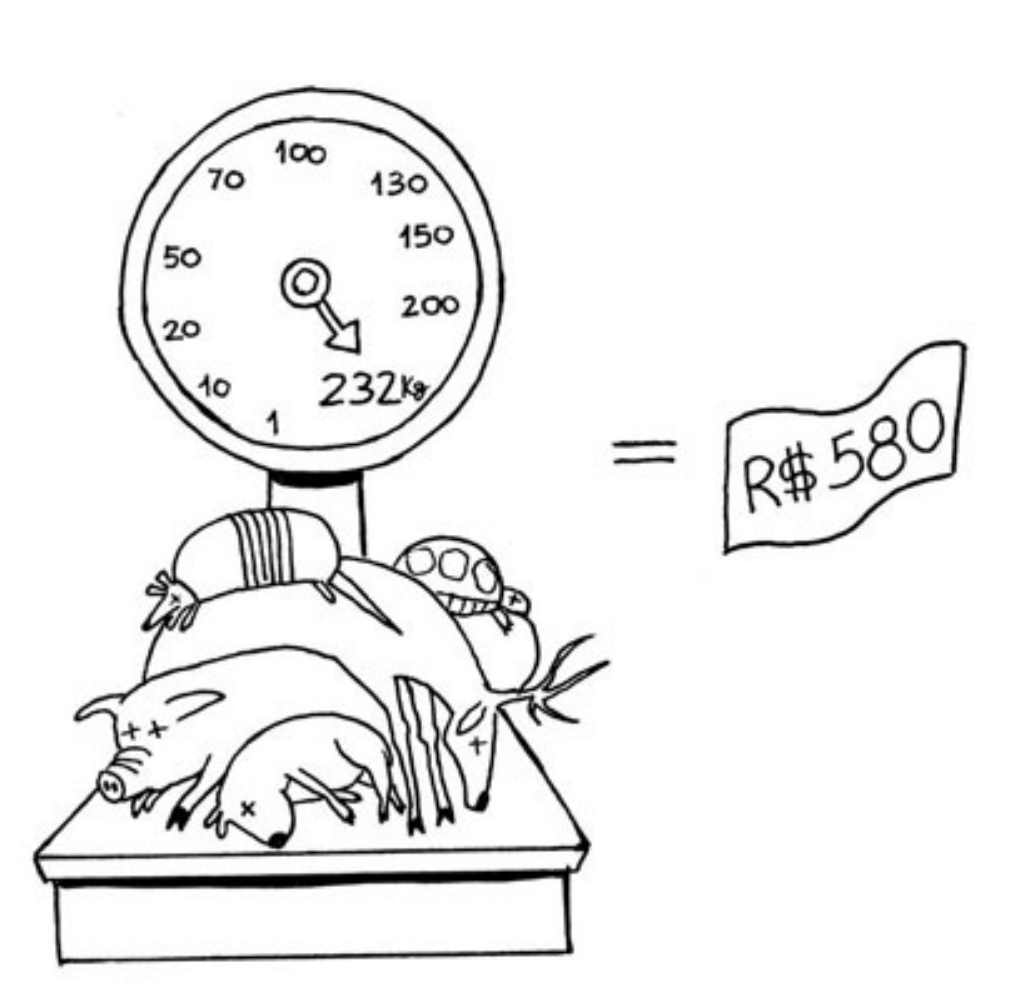
Fig. 3. The cost of game meat captured freely in the forest if purchased in the local market. Source: Cymerys in Shanley and Medina